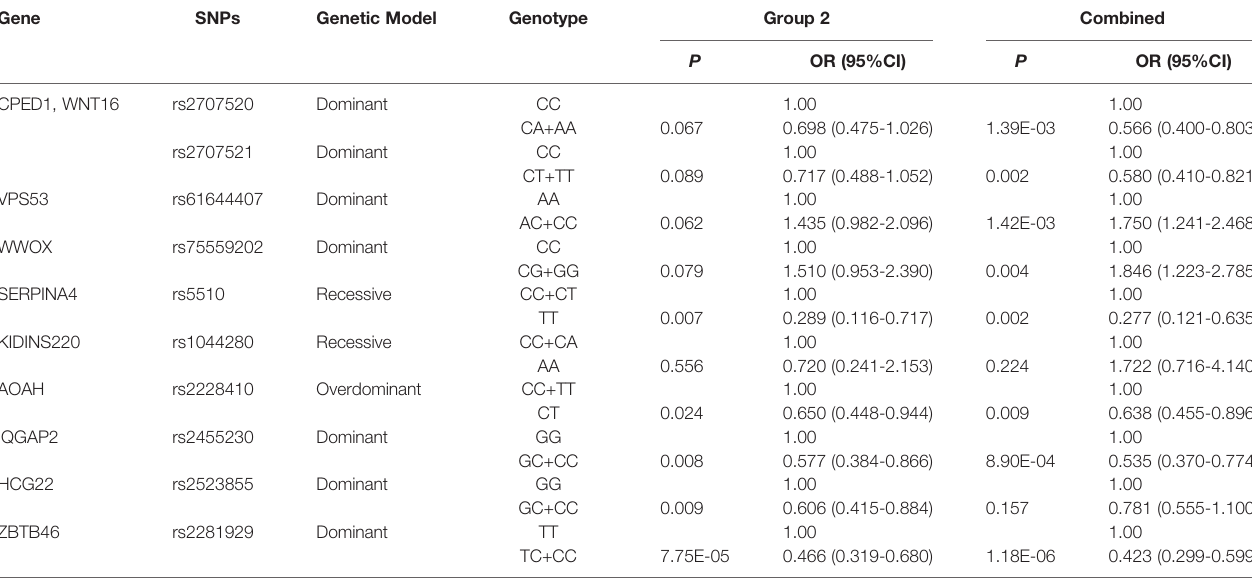
TABLE 3 | Multivariate logistic regression analysis adjusted for age and